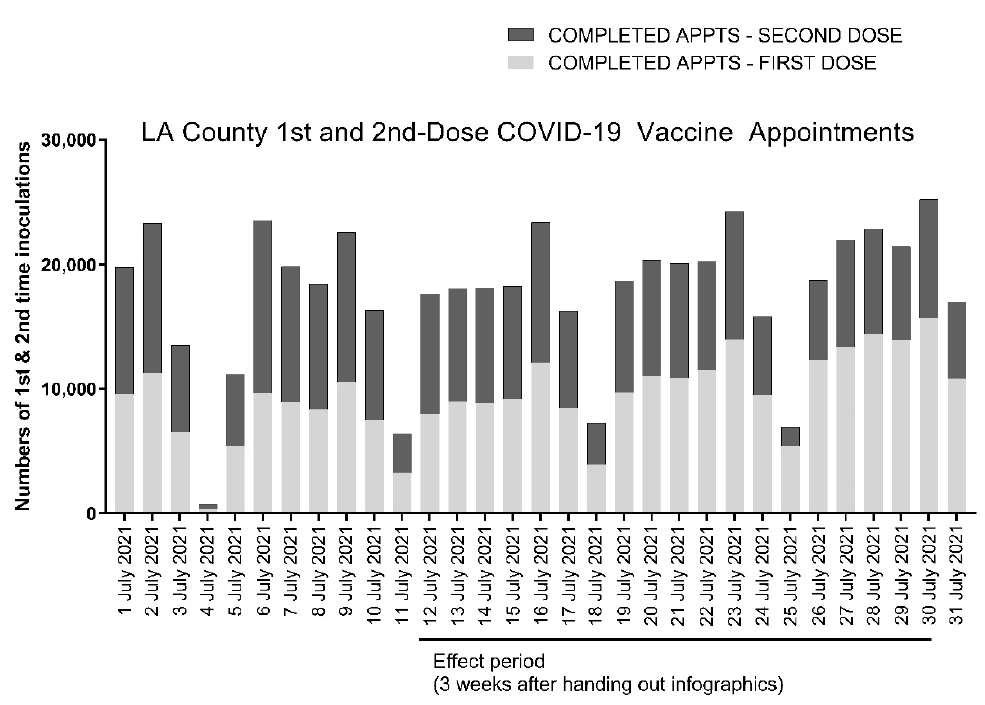
Figure 3. Anonymized county-wide data from the California Department of Public Health for Los Angeles County showing daily numbers of first- and second-dose recipients of the Pfizer and Moderna two-dose COVID-19 vaccines. The effect period shown corresponds to the dates of our study at the Lincoln Park COVID-19 POD from 12 to 30 July. First-dose appointments are shown with light gray bars and second-dose appointments with dark gray bars.